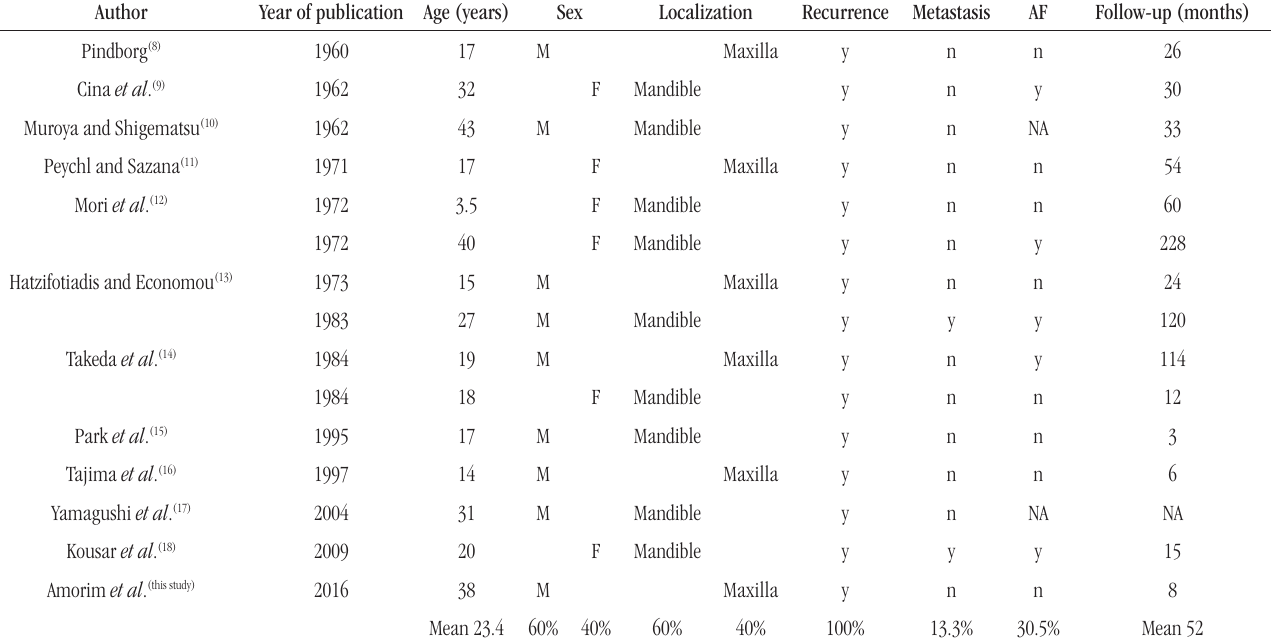
taBLE − Features of the fatal AFS cases in the current English